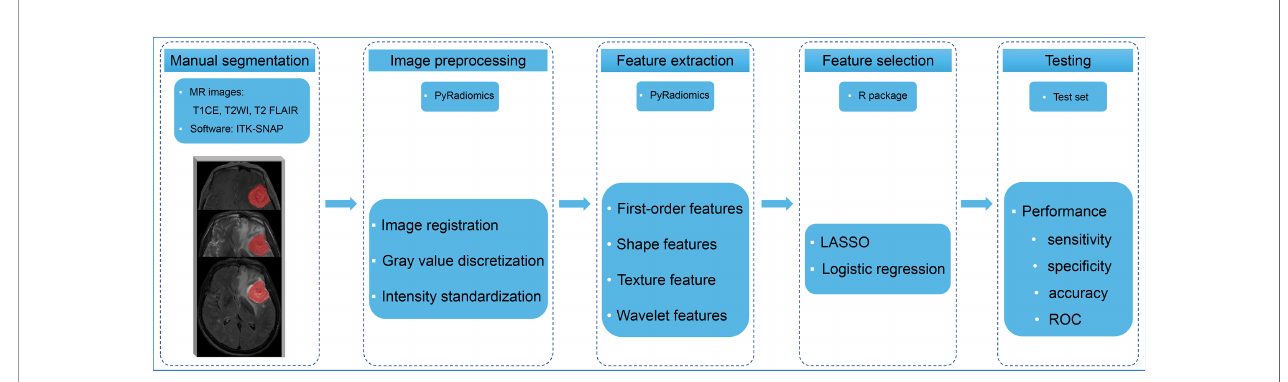
FIGURE 2 | The radiomics analysis work fl ow Multiple-sequence MR images were selected and manually contoured. The radiomic features were extracted and selected from processed images to build models to predict the EGFR status of brain metastases. The performance of the models was evaluated using an independent test set. T1CE, contrast-enhanced T1-weighted imaging; T2WI, T2-weighted imaging; T2 FLAIR, T2 fl uid-attenuated inversion recovery; LASSO, least absolute shrinkage and selection operator; ROC, receiver operating characteristic